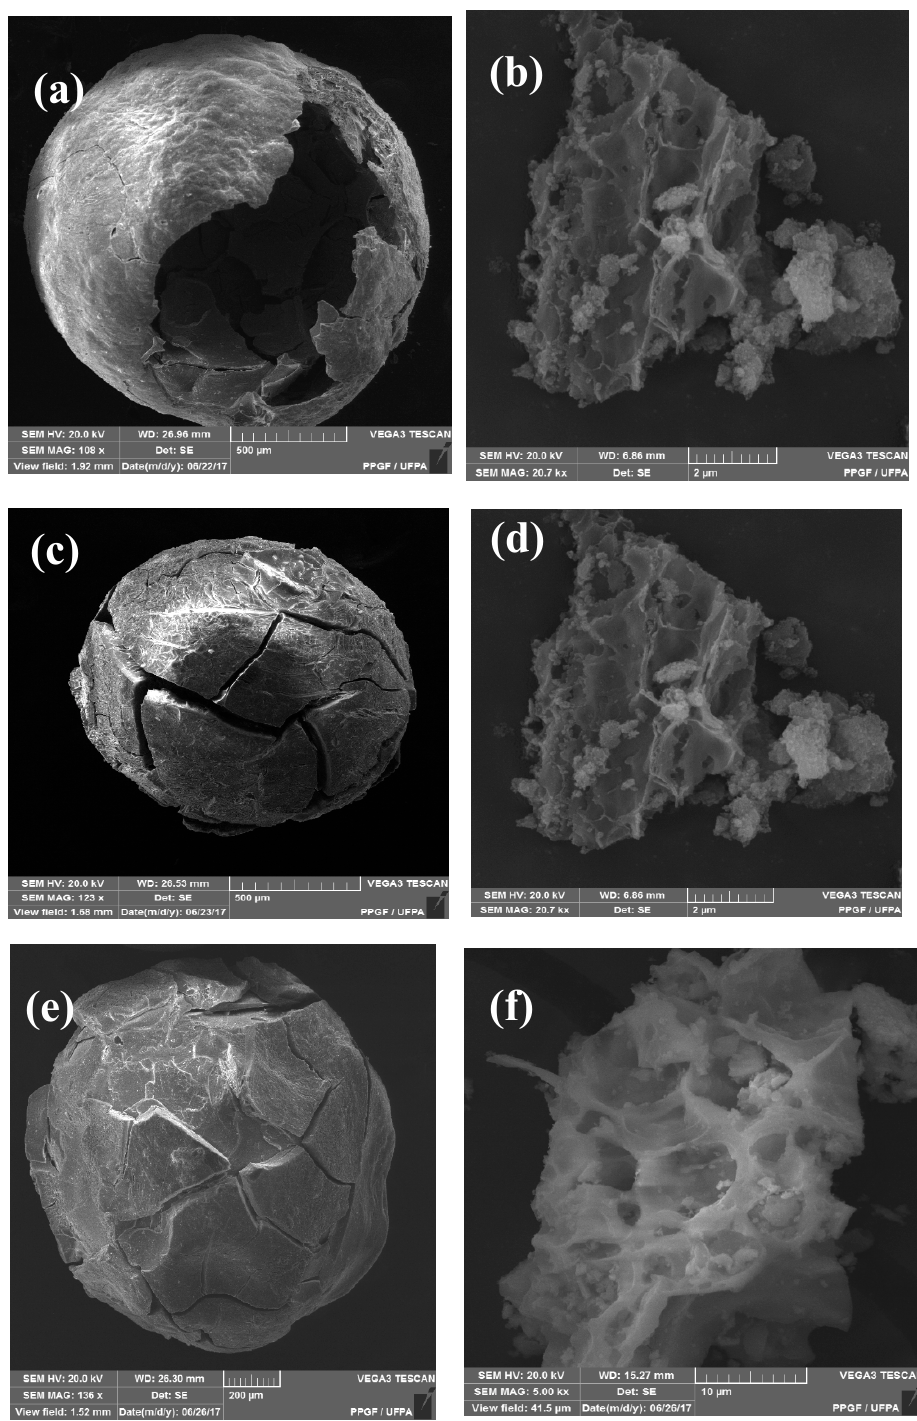
Figure 3. Scanning electron micrographs of samples ( a ) and ( b ) ZnAl 2 O 4 –750; ( c ) and ( d ) NiAl 2 O 4 –950; ( e ) and ( f ) CoAl 2 O 4 –750.